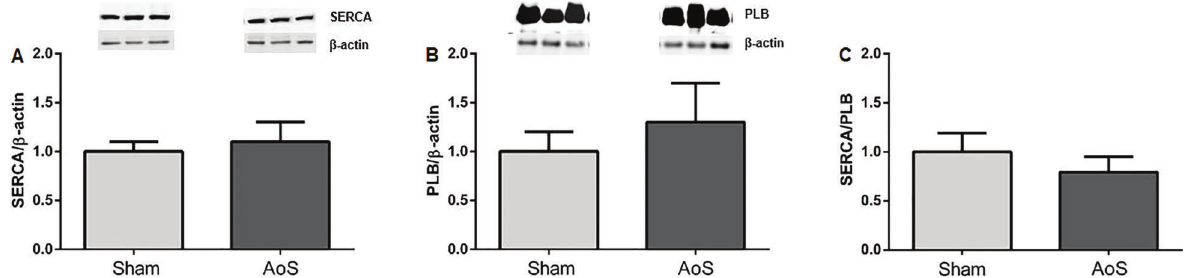
Figure 3. Protein expression of sarcoplasmic reticulum calcium ATPase (SERCA) ( A ) and phospholamban (PLB) ( B ) and relationship between SERCA and PLB ( C ), from aortic stenosis (AoS, n=6) and control group (Sham, n=6). Data are reported as means ± SD. P values were 0.32, 0.12, and 0.16, respectively, vs Sham (Student ’ s t -test).